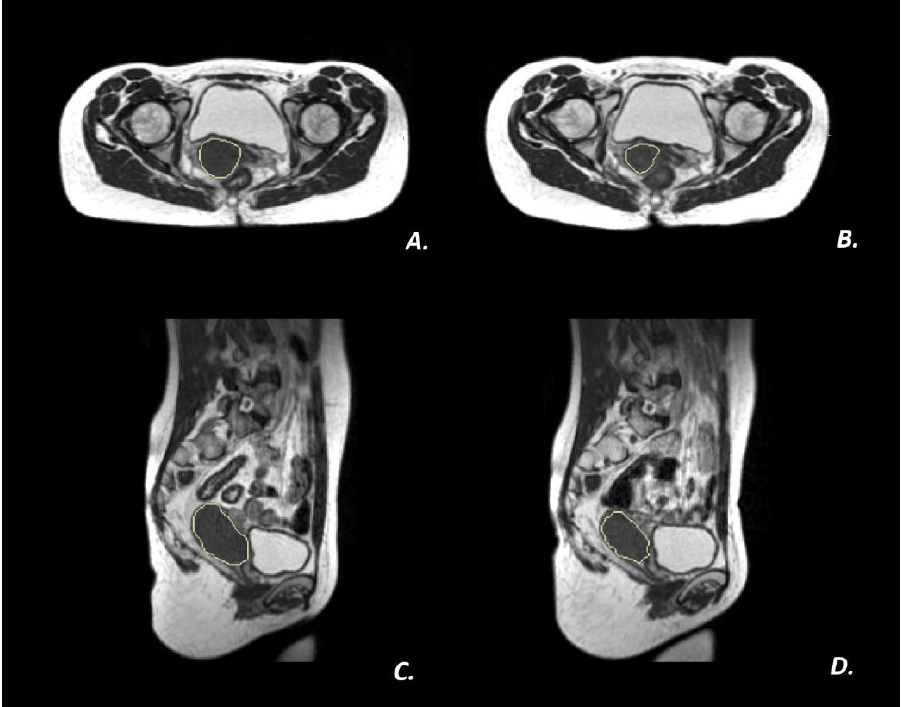
Figure 1. Gross tumor volume (GTV) delineated on simulation imaging and at fraction 10 in axial ( A ) and ( B ) and sagittal plan ( C ) and ( D ).